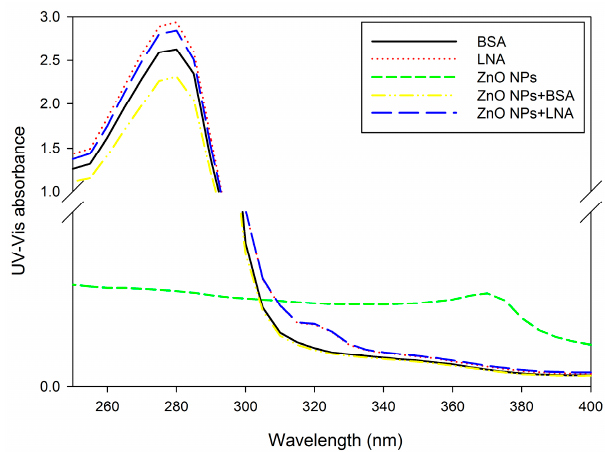
Figure 3. The UV-Vis spectra of bovine serum albumin (BSA), α -linolenic acid (LNA complexed to BSA; referred as LNA) and ZnO NPs (code: XFI06) suspended in distilled and deionized water (DDW), 0.5% BSA, or 200 µM LNA. Distilled and deionized water (DDW) was used as a blank.